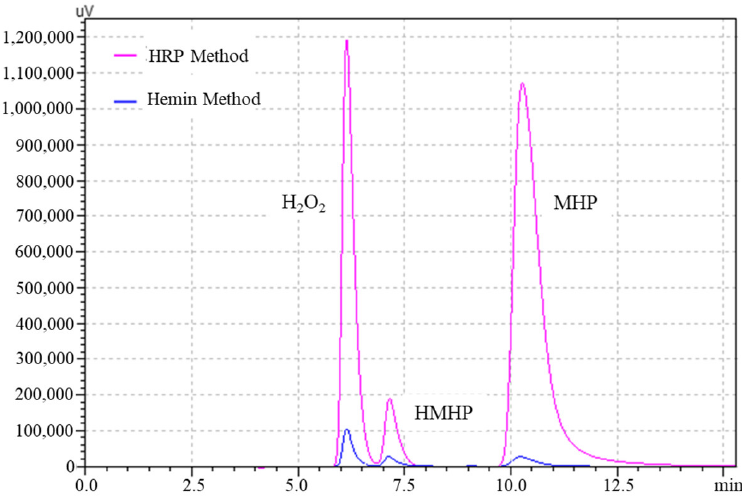
Figure 8. Chromatogram of peroxides analysed by two methods. Table 4. The concentration and flow rate of HRP in the reaction system used in this study and ref. [14].